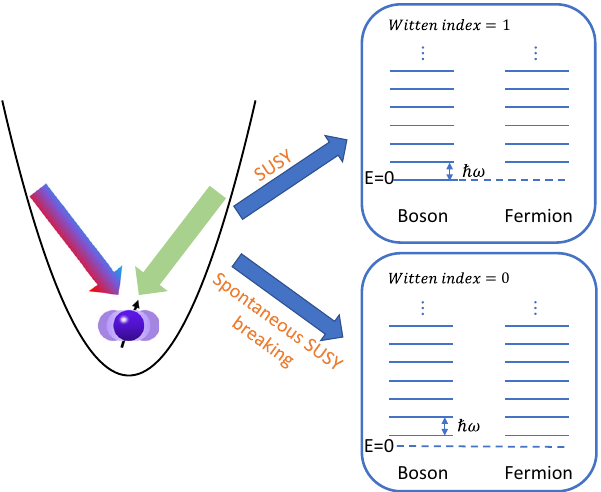
Fig. 1 Quantum Simulation of SUSY and its spontaneous breaking. We simulate the QRM Hamiltonian by coupling the internal states of an ion with its spatial oscillation using bichromatic Raman laser beams. Under suitable parameters, the system possesses SUSY and there is a unique E = 0 bosonic ground state with all the other excited states being double- degenerate for bosonic and fermionic states. This corresponds to a Witten index of one. When moving to a different set of parameters, the Hamiltonian is still supersymmetric, but this symmetry spontaneously breaks and the ground states are no longer unique but obtains nonvanishing supercharges and positive energies. The Witten index in this case is